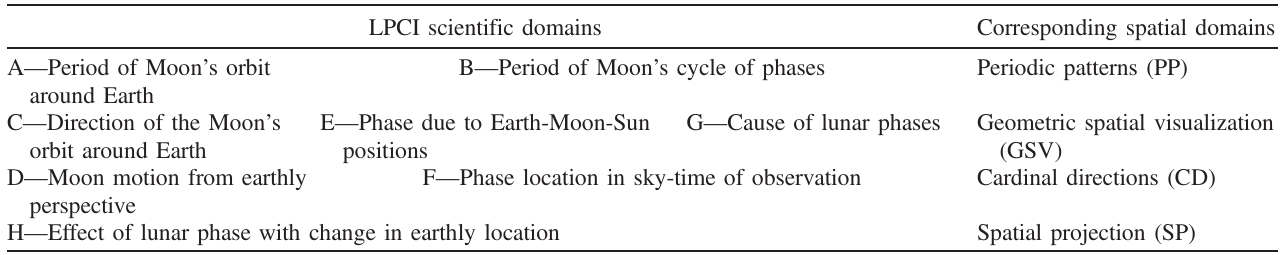
TABLE II. Concept domains: LPCI science domains and corresponding spatial domains [4]. LPCI scientific domains